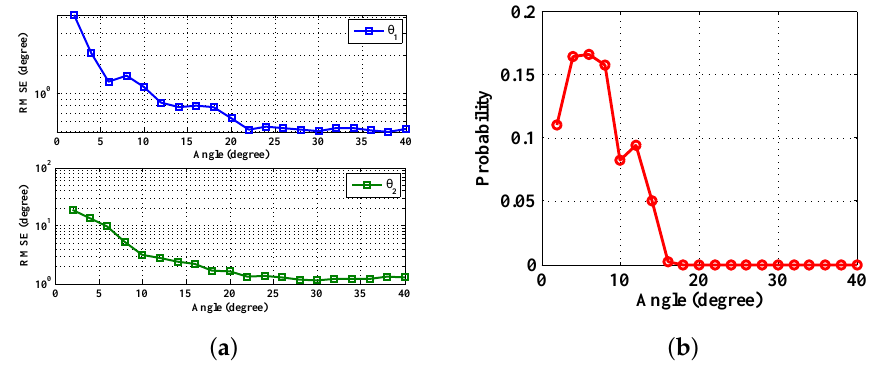
Figure 8. Angle separation comparison: ( a ) RMSE versus angle ( b ) false probability versus